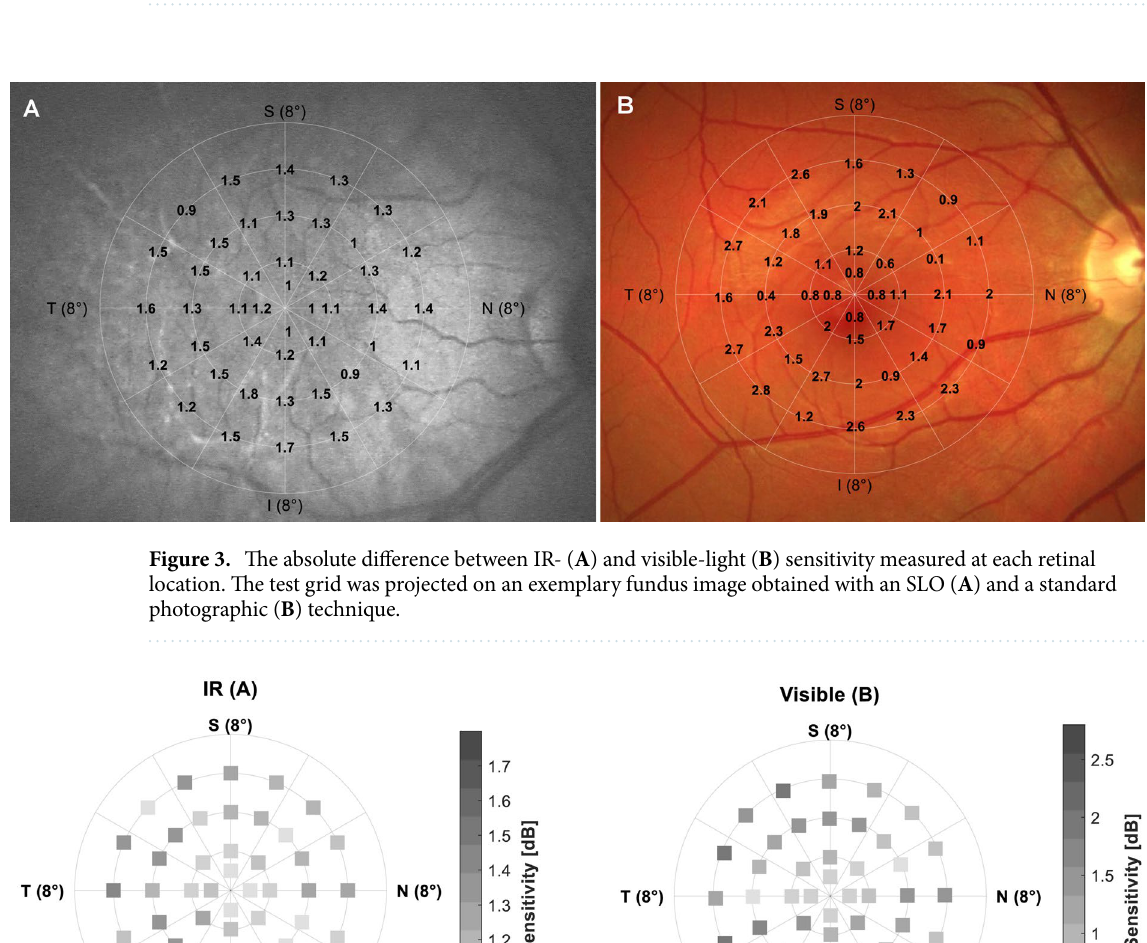
Table 2. The retinal nerve fiber layer thickness measured in the control and glaucoma groups. *Mann– Whitney U-test.